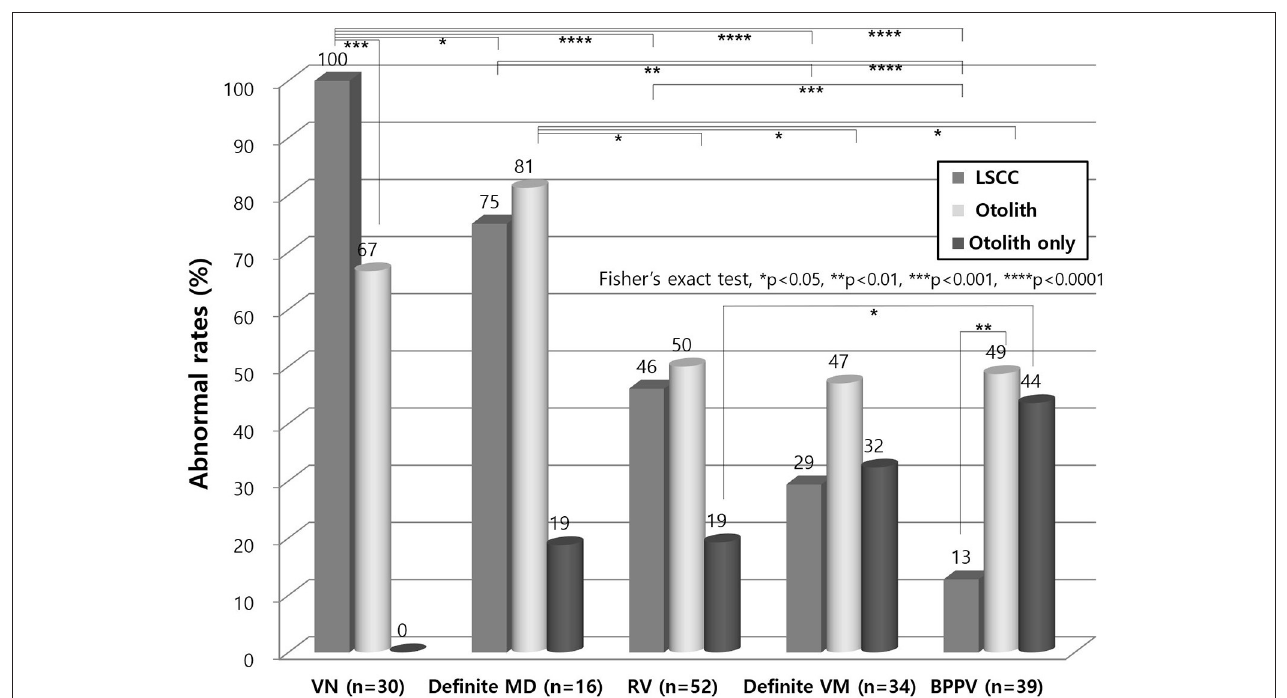
FIGURE 3 | Lateral canal and otolith dysfunction in vestibular disorders. Lateral canal dysfunction was more common than otolith dysfunction in VN ( p < 0.001). Other vestibular disorders showed higher otolith dysfunction than lateral canal dysfunction which was a significant difference in patients with BPPV ( p < 0.01). Isolated otolith dysfunction was the most found in BPPV. LSCC, lateral semicircular canal; VN, vestibular neuritis; MD, Meniere’s disease; RV, recurrent vestibulopathy; VM, vestibular migraine; BPPV, benign paroxysmal positional